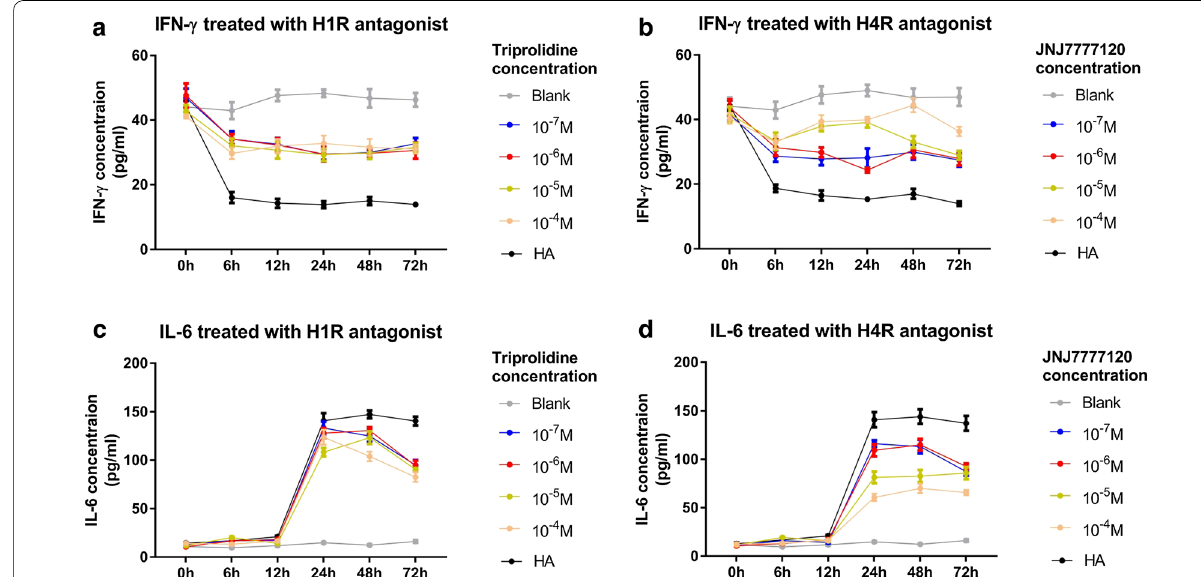
Fig. 1 IFN-γ and IL-6 secretion upon treatment with H1R or H4R antagonist. IFN-γ ( a , b ) and IL-6 ( c , d ) production was observed in U937 cells, which were challenged by histamine first and then treated by H1R (triprolidine) or H4R (JNJ7777120) antagonist under different dose and time points. Data are shown as the mean ±